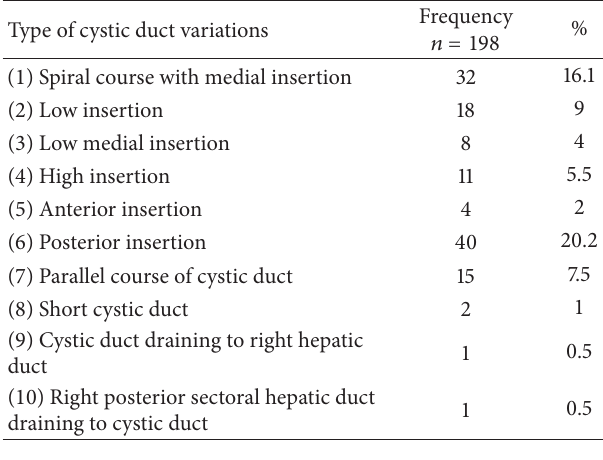
Table 1: Distribution of different anatomical variations of cystic duct.